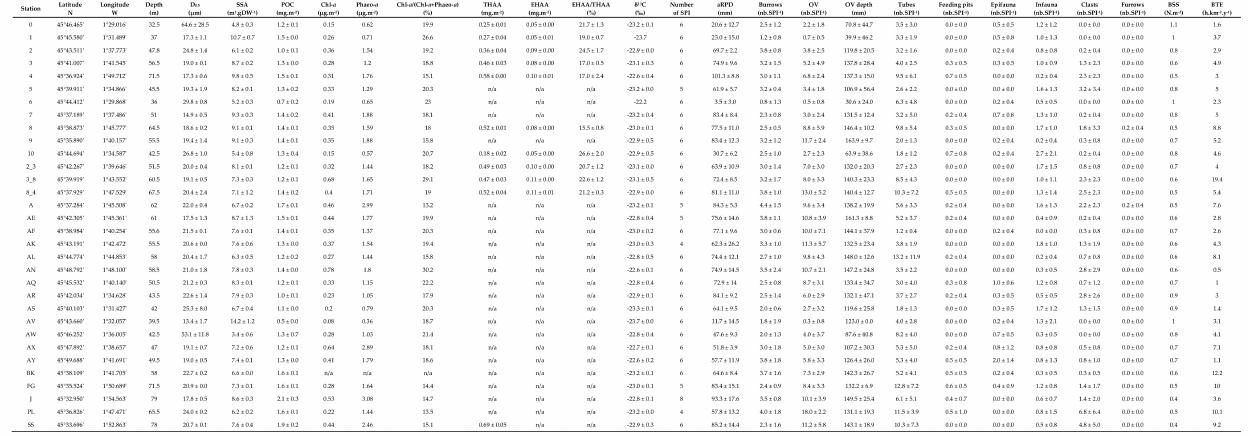
Table A2. Determination coefficients (R 2 ), associated probability levels ( p ), slopes and intercepts